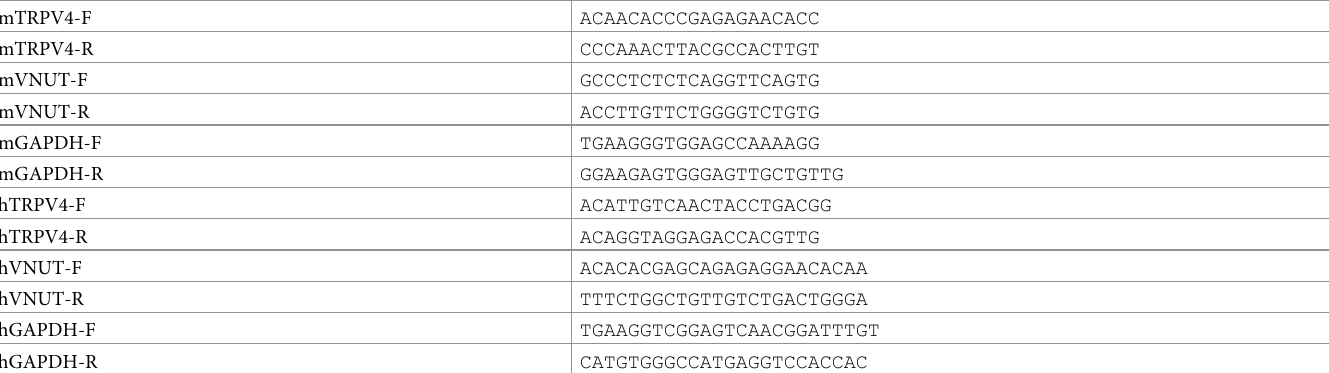
Table 1. Primer sequences for RT-PCR and qRT-PCR.